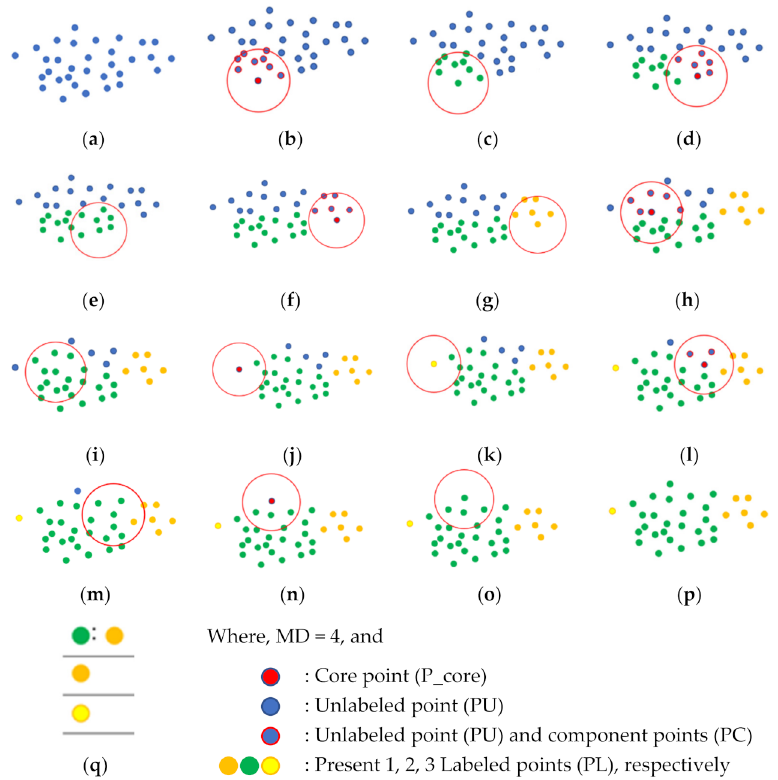
Figure 2. Example of the temporary labeling stage process: ( a ) original unlabeled data points; ( b – o ) seven times of the core point selection and labeling process; ( p ) output data labeled with temporary values; ( q ) resultant